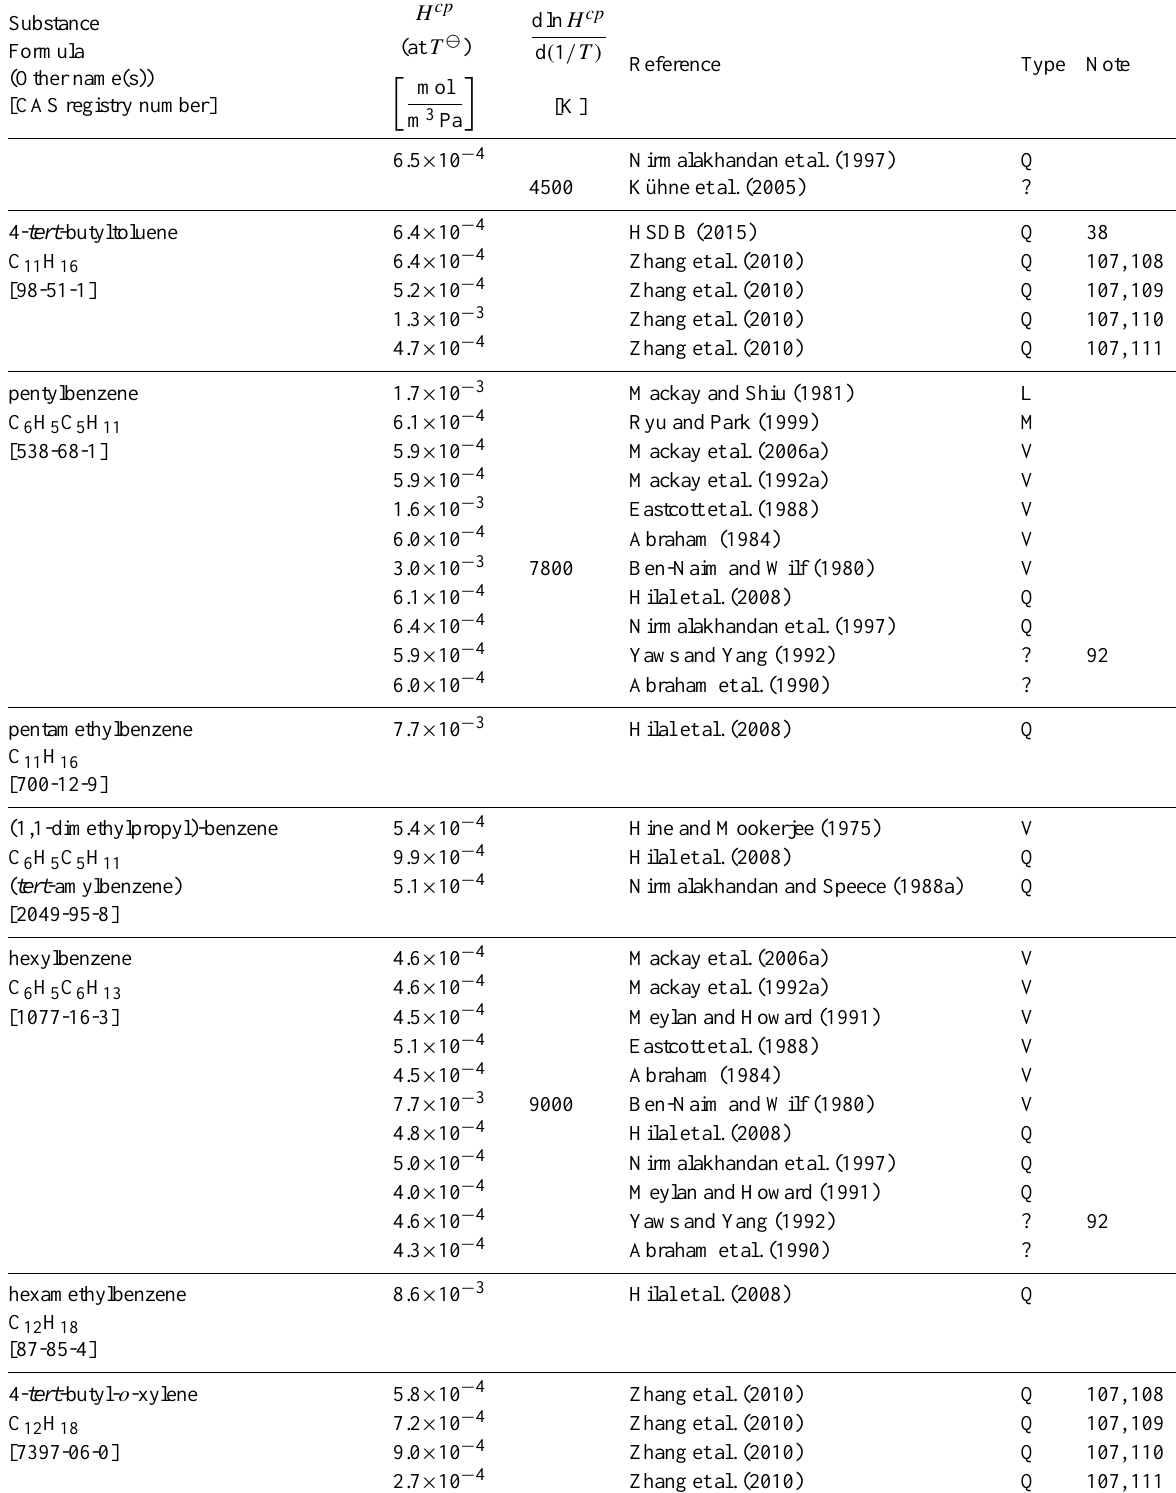
Table 6: Henry’s law constants for water as solvent